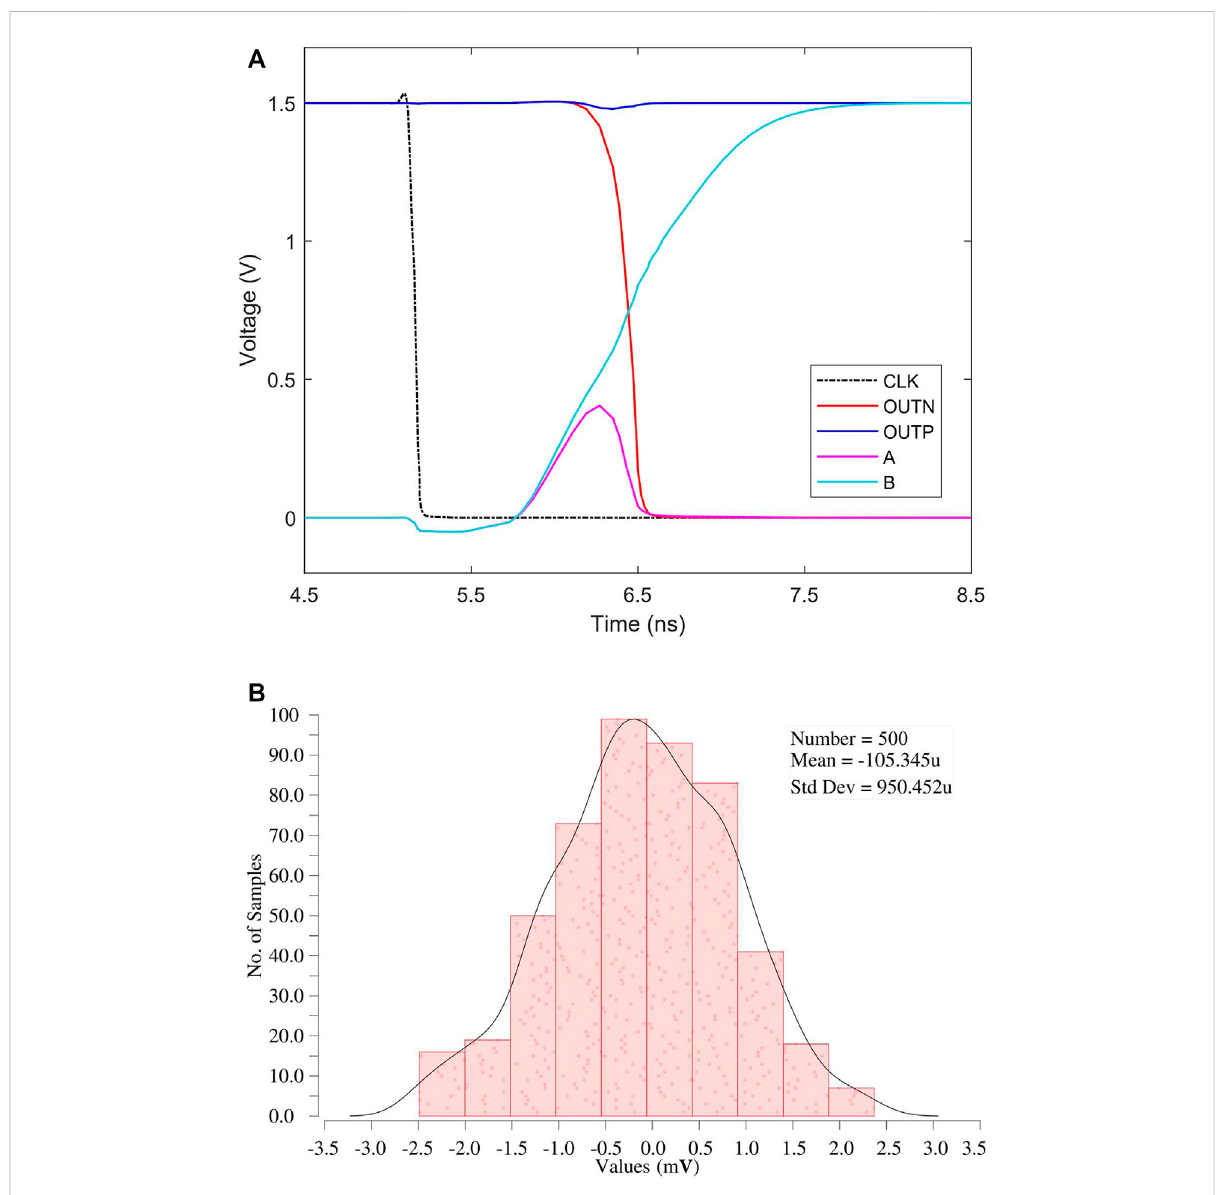
Figure 8. From the fi rst comparison to the (N-1) th comparison, the common-mode voltage remains V cm , and in the last comparison, the common-mode voltage shifts by one LSB. Figures 9A, B show the 500 times Monte Carlo simulation results of the proposed DAC switching